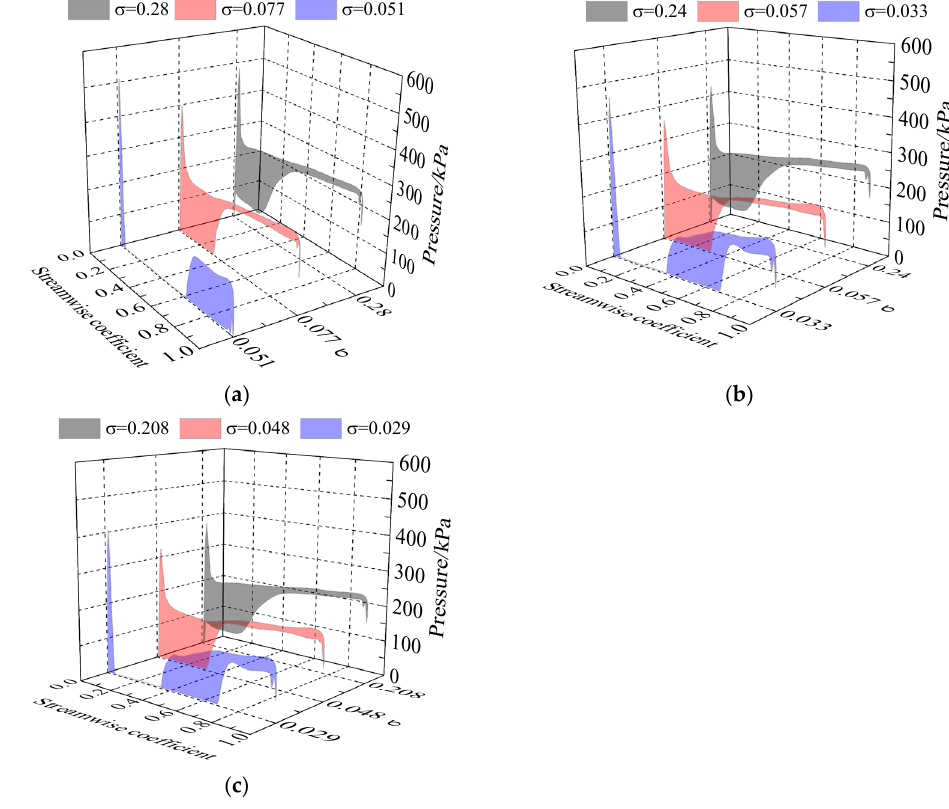
Figure 8. Pressure on 0.5 blade span at IGVF = 0, 0.1, 0.2. ( a ) IGVF = 0; ( b ) IGVF = 0.1; ( c ) IGVF = 0.2.